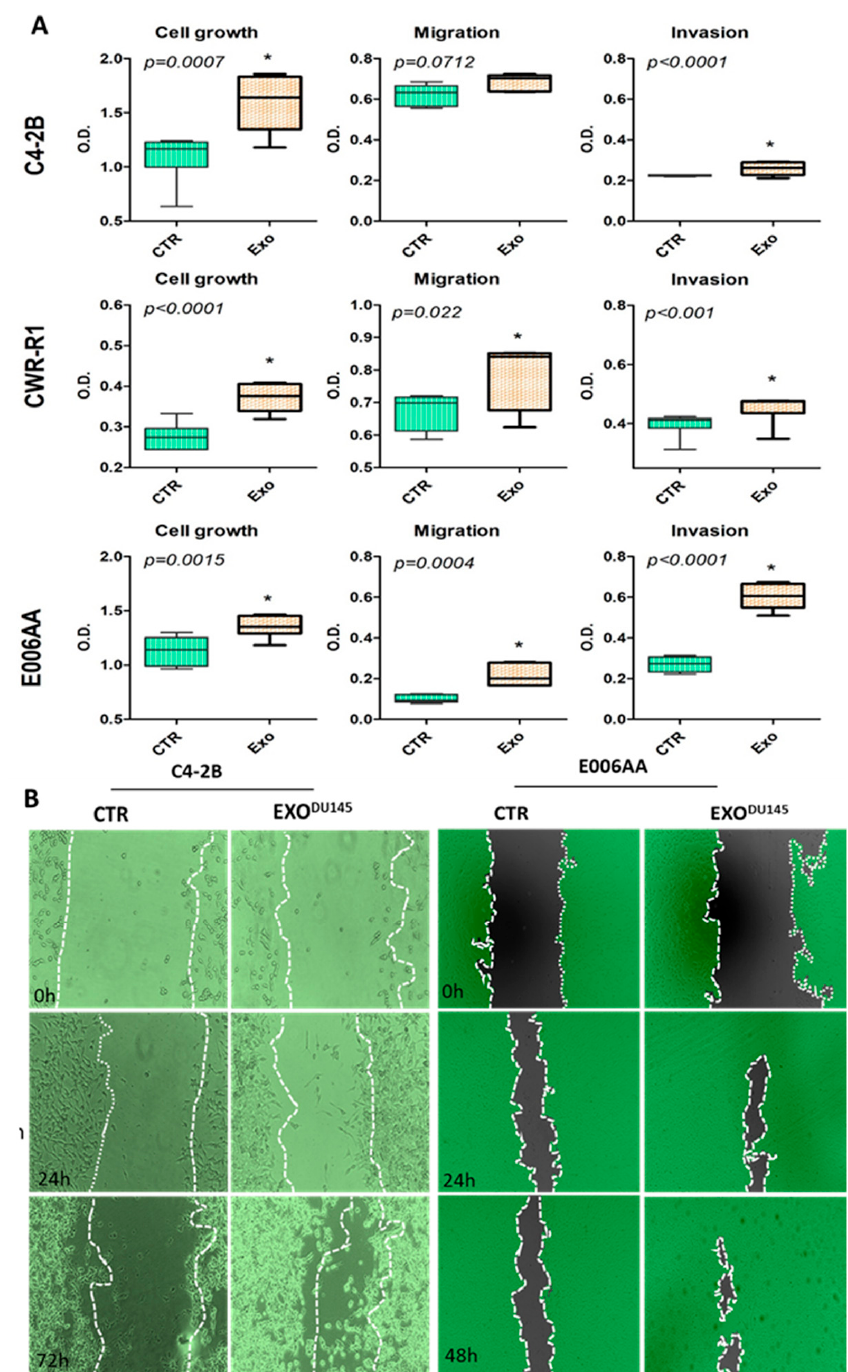
Figure 4. Functional significance of exosomes-mediated transfer of ITGA2 into PCa cells. ( A ) C4-2B, CWR-1Rca and E006AA cells were incubated with 10 µ g / mL exosomes derived from PC-3 or DU145- for 3 days then cell proliferation assay was performed. Representative transwell migration and invasion assays are presented for C4-2B, CWR-1Rca and E006AA cells treated with or without 20 µ g / mL exo PC-3 for 24 h. ( B ) Wound-healing assay was performed on C4-2B and E006AA cells incubated with or without exosomes derived from DU145 cells up to 72 h in 6-well plates. Each treatment was conducted in triplicate and at least 6 fields were captured under inverted bright microscope. * depicts significance at p < 0.05. Each experiment was performed in triplicate and independently repeated